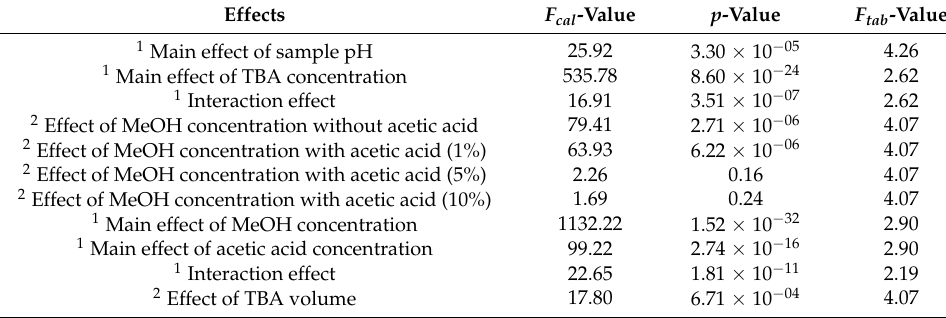
Table 1. F -Values and p -Values obtained from the variance analysis of the experimental